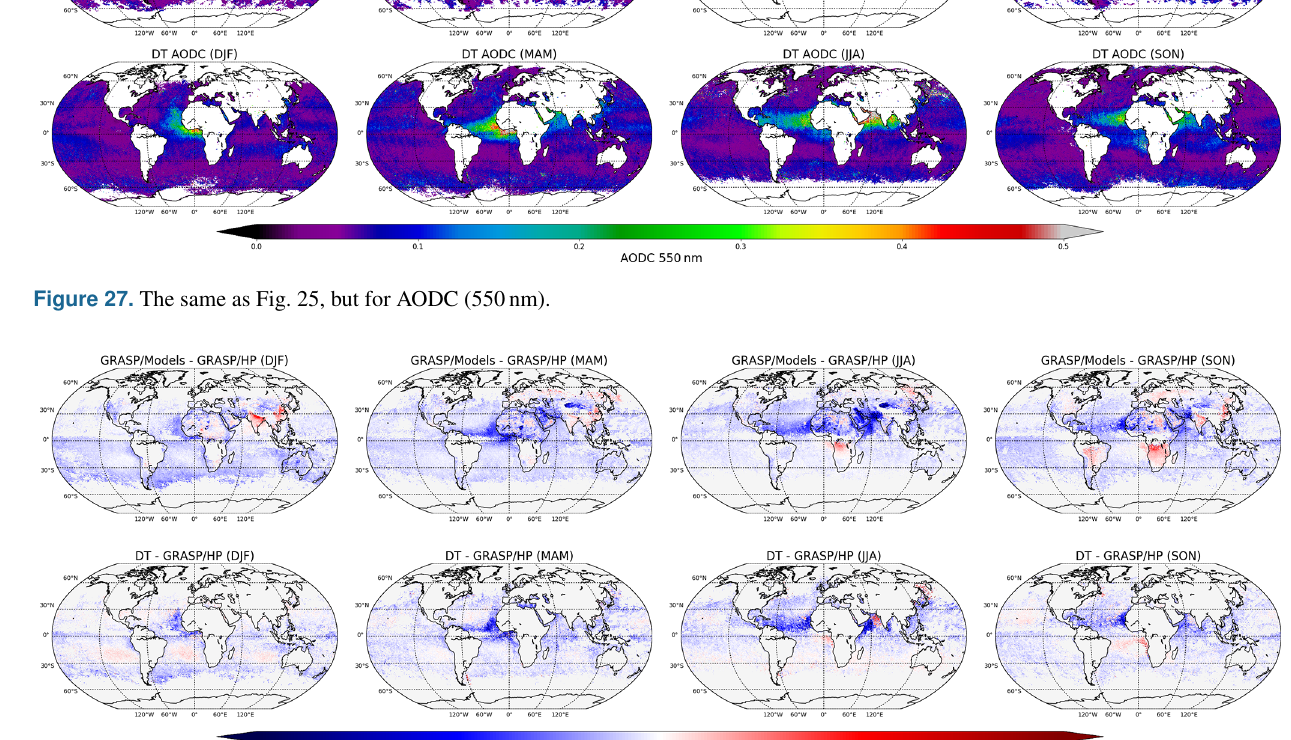
Figure 28. The same as Fig. 26, but for AODC